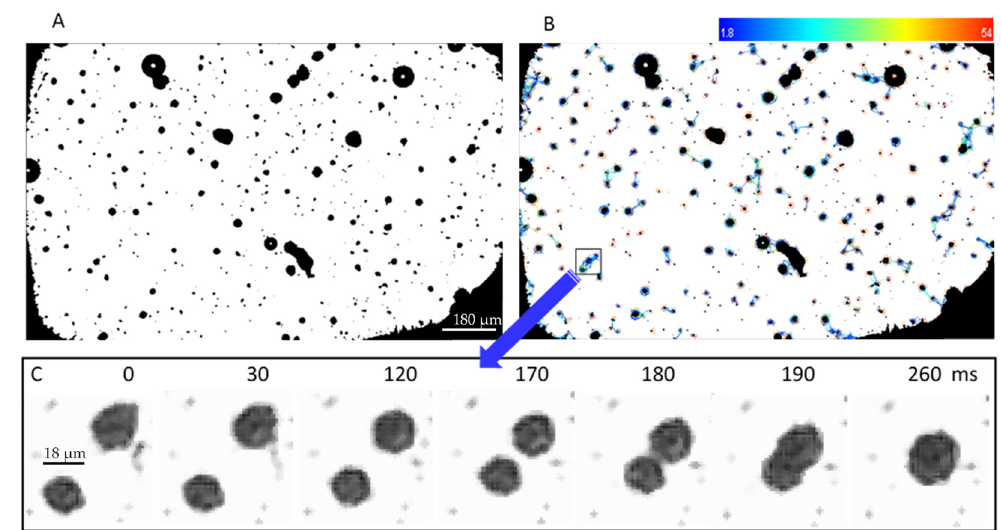
Figure 5. Microbubbles dynamics over time displayed in a motion history image. ( A ) Original MB image extracted from video data; ( B ) image analysis using the Fiji TrackMate interface—the color scale indicates track displacement in arbitrary units; ( C ) one example of MB trajectory visualization: Frames #1 − #260 show coalescence of two MB clusters (known as “bubble grapes”).